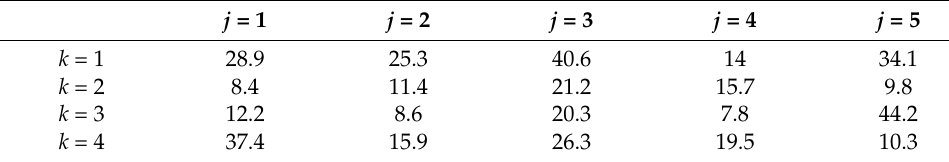
Table 7. Linear distance of DC jk.